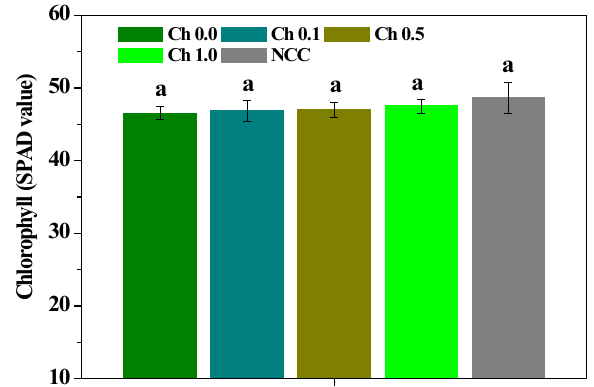
Figure 2. The influence of chitosan spraying on the chlorophyll content of P. ternata leaves. Error bars show SD, and different letters indicate significant differences at 5% ( p < 0.05) level.